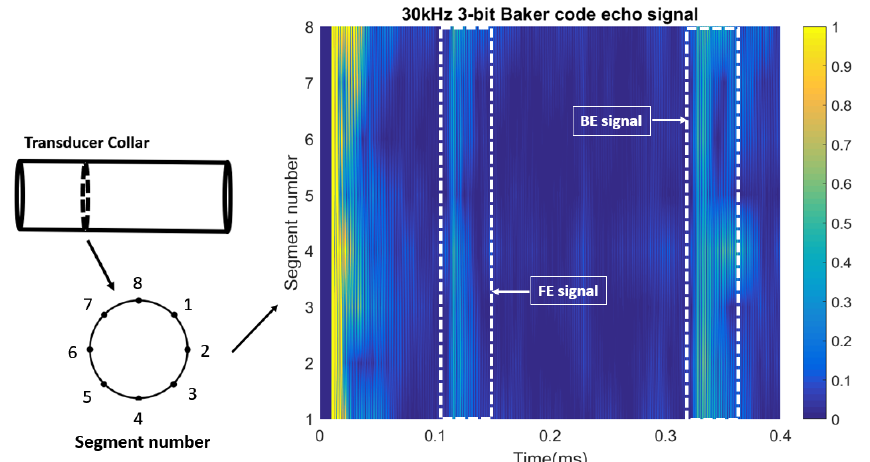
Figure 8. The raw experimental echo signals of a 3-bit Barker code at 30 kHz from eight segments of the pipeline inspection system. Notes: the experimental setup detail of the pipeline is shown in Figure 6.